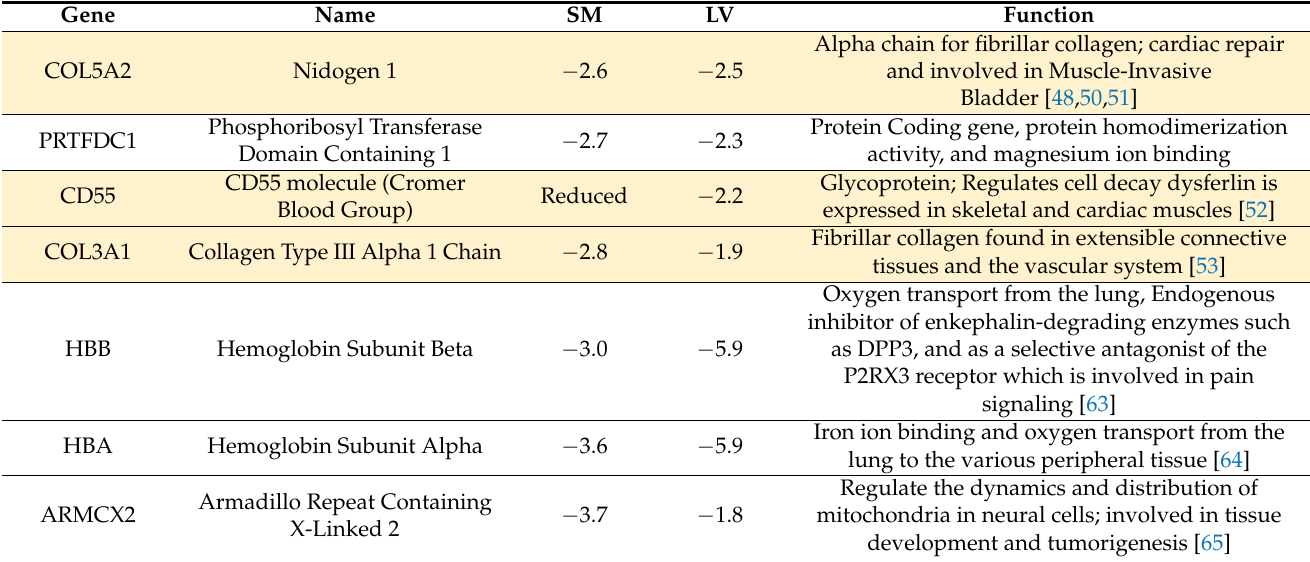
Yellow highlighted rows indicate those with relevant muscle and/or heart functions. SM = skeletal (intercostal) muscle, LV = left ventricular (cardiac muscle).